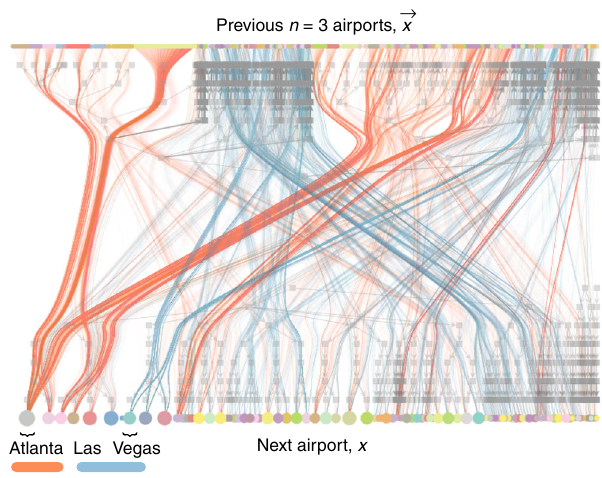
Fig. 3 Selection of US fl ight itineraries for a third-order model. The itineraries contain stops in Atlanta or Las Vegas. Edges incident on memories of the type x = ( x t − 1 , Atlanta, x t − 3 ) in red and x = ( x t − 1 , LasVegas, x t − 3 ) in blue . The node colours and overlaid hierarchical division derive from the n = 3 model inferred for the whole